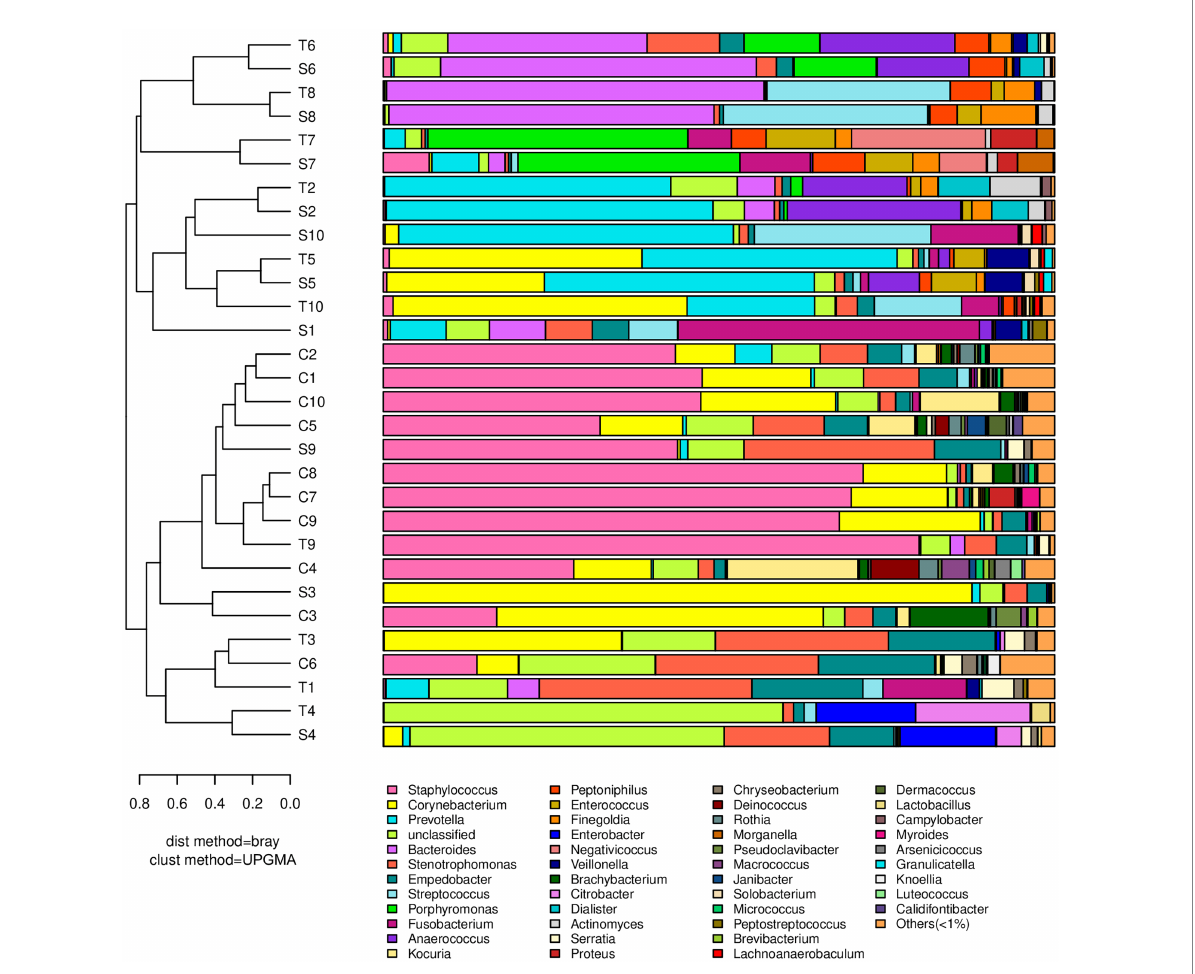
FIGURE 1 A dendrogram and histogram of the bacterial composition at the genus level. The dendrograms were constructed based on the unweighted pair group method with the arithmetic mean (UPGMA). The bacterial compositions of samples are more similar to each other with closer evolutionary relationships. The histogram visualizes the relative abundance of each sample at the genus